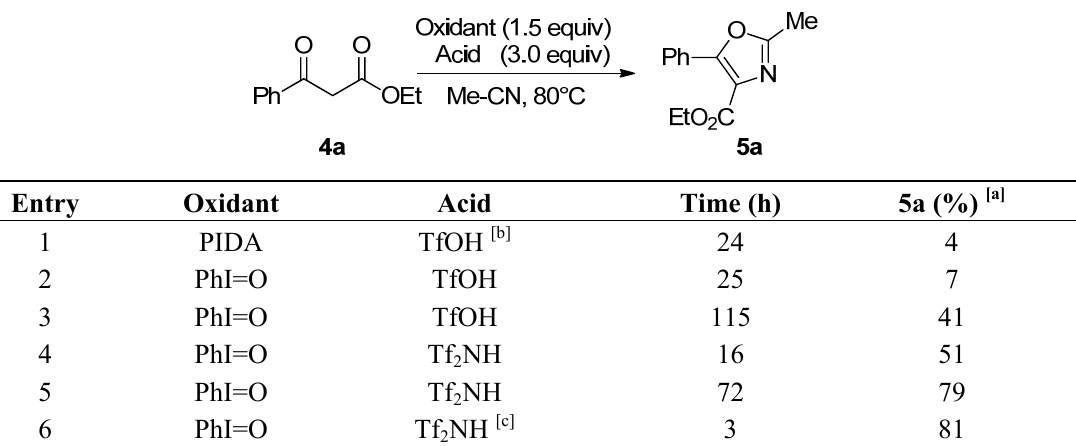
Table 2. Evaluation of oxidants for the reaction of benzoylacetate 4a in